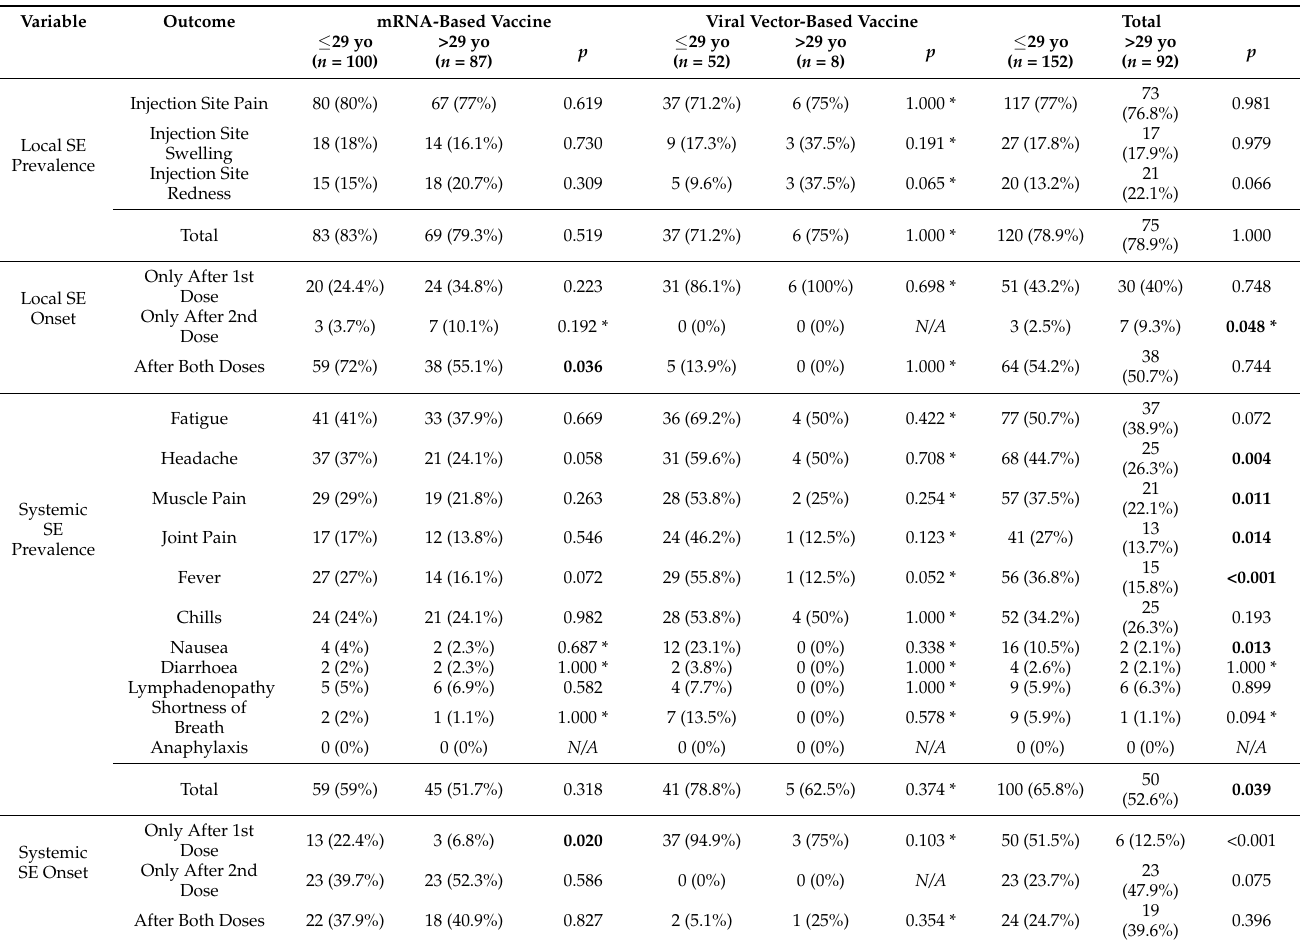
Figure 3. Distribution of COVID-19 Vaccines SRAEs by age. Table 9. Local, systemic, orofacial and skin-related SRAEs and palliative drugs following COVID-19 vaccination stratified by